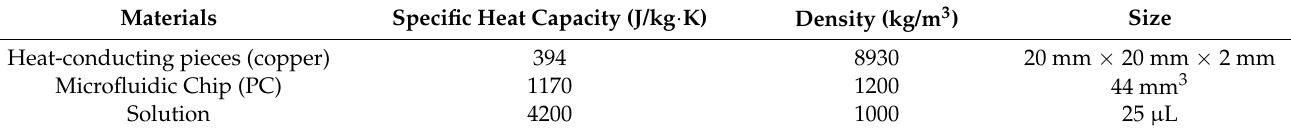
Table A1. Material